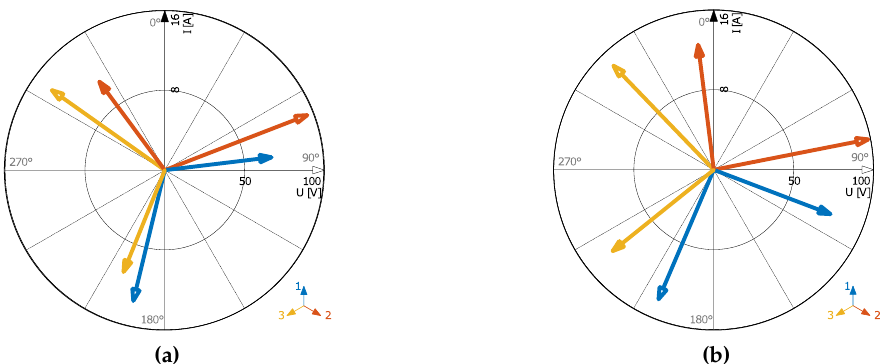
Figure 21. C2—Vector diagram of 5th harmonic of the medium voltage feeder voltage and current ( a ) before and ( b ) after switching on the capacitor stage.